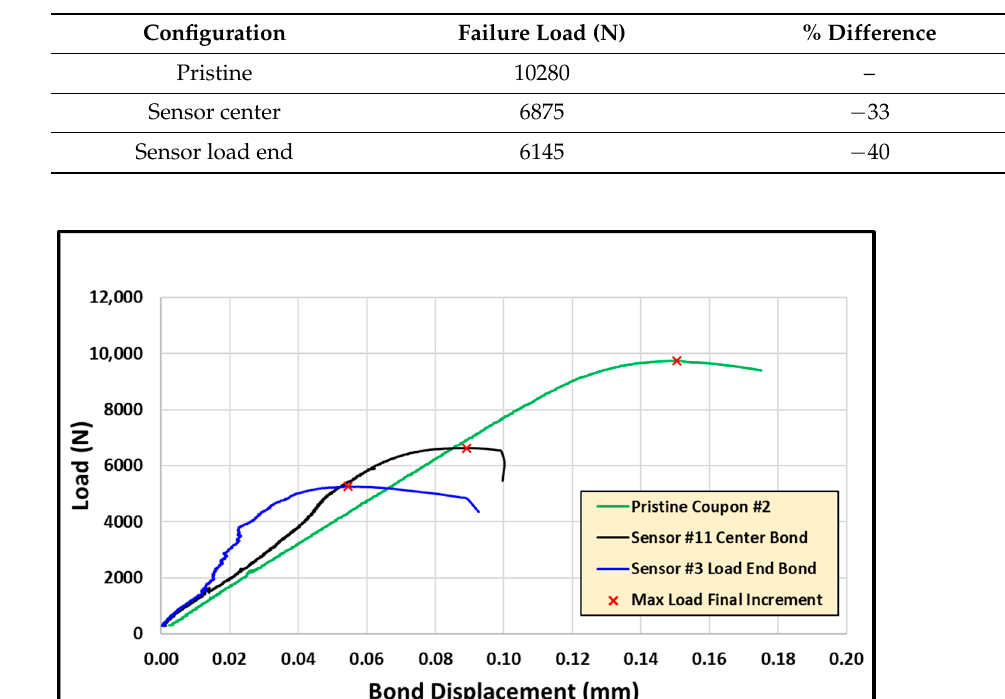
Figure 23. Load versus displacement of pristine and sensor